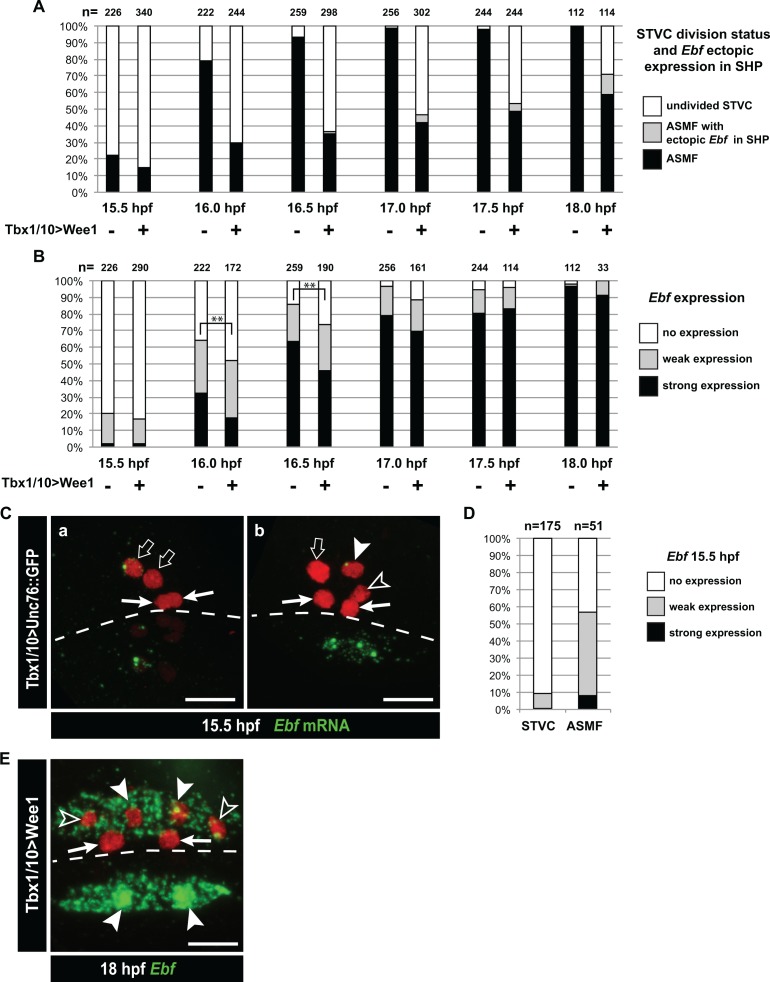
Dynamics of Ebf upregulation and entrainment by the cell cycle.(A) Proportions of larva halves fixed at successive time points and showing undivided STVCs, or ASMFs with or without ectopic Ebf expression in the SHPs following STVC-specific expression of the G2/M inhibitor Wee1 (+), or a control construct (-). See Figure 5—figure supplement 1E for an example of ectopic Ebf expression in the SHPs (grey labels). Note the sharp increase in % of larva with ASMF nbetween 15.5 and 16hpf, indicating that mitosis occurs primarily during this time window, but is delayed in a majority of larvae upon Wee1 misexpression. (B) Proportions of larva halves with cells showing indicated Ebf expression. The numbers (n) for cells expressing Wee1 focus on cells that have not divided (% shown in E), to estimate the dynamics of Ebf activation in G2/M-inhibited cells. Control cells consist mostly ASMFs after 15.5hpf as shown in (E). Wee1 and controls distributions differ significantly only at 16 and 16.5hpf (**, p<0.01, Chi2 test), suggesting that Wee1 merely delays the accumulation of Ebf transcripts. (A) 15.5hpf Cardiopharyngeal lineage cells expressing Mesp > H2B::mCherry (red) and control Tbx1/10 > unc76::GFP construct (not visible). Rare precocious activation of Ebf transcription in STVCs. (C.a) Green nuclear dot indicates nascent Ebf transcription in an STVC (open arrow), but not the other, and not in the first heart precursors (FHP; arrow). (C.b) left pair of nuclei shows an STVC (open arrow) and an FHP (arrow), neither of which express Ebf, whereas the cousin ASMF (solid arrowhead) shows nascent Ebf transcription (green dot). Dotted line: midline. (D) Proportions of STVCs and ASMFs showing indicated Ebf expression patterns. Note that > 90% of STVCs do not express Ebf, which turns on almost exclusively in ASMFs. (E) Cardiopharyngeal lineage cells with Ebf expression in the ASMFs (solid arrowheads), and ectopically in the SHP (open arrowheads), but not in the FHPs (arrows), following misexpression of Wee1 using the STVC-specific Tbx1/10 T12 enhancer. Dotted line: midline.